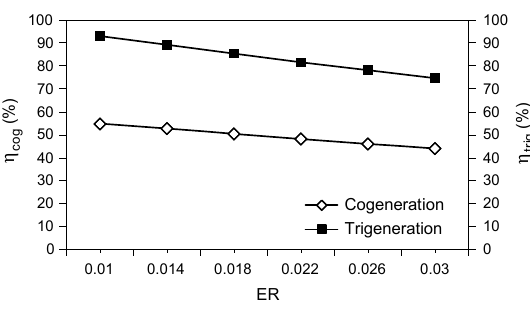
Figure 4. System cogeneration and trigeneration average efficiencies as a function of the ER.